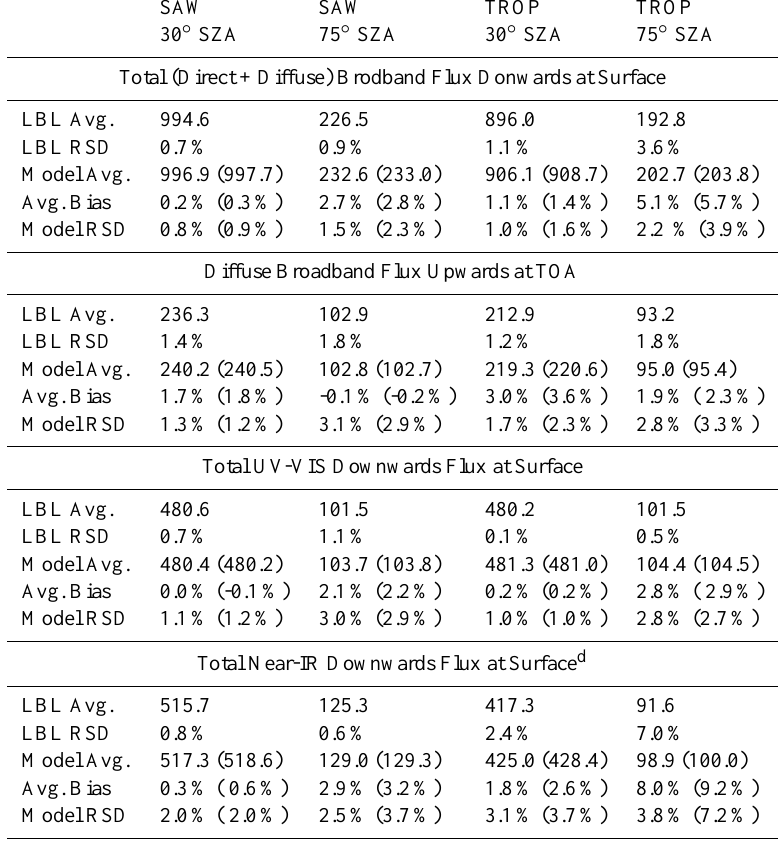
Table A3. Case 2a: summary statistics for scattering aerosols a , b , c